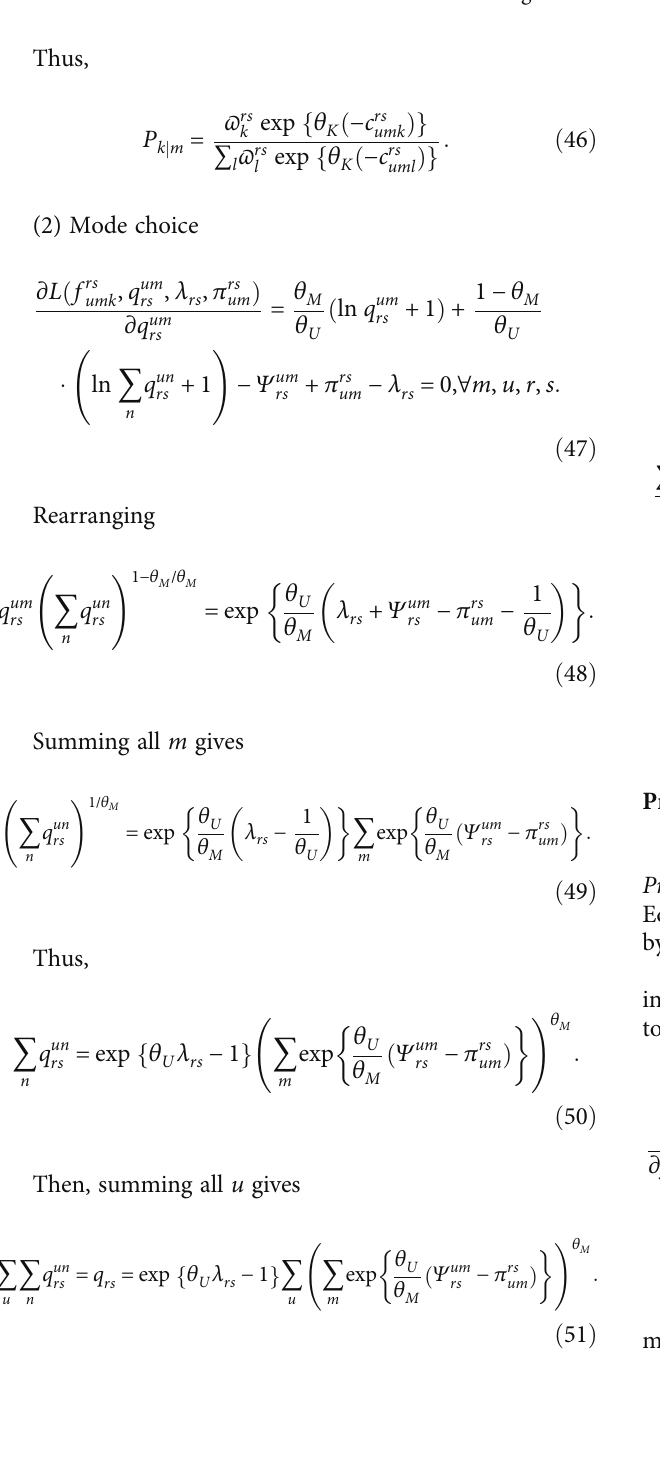
Algorithm 2: The SAB algorithm for the reserve network capacity model.